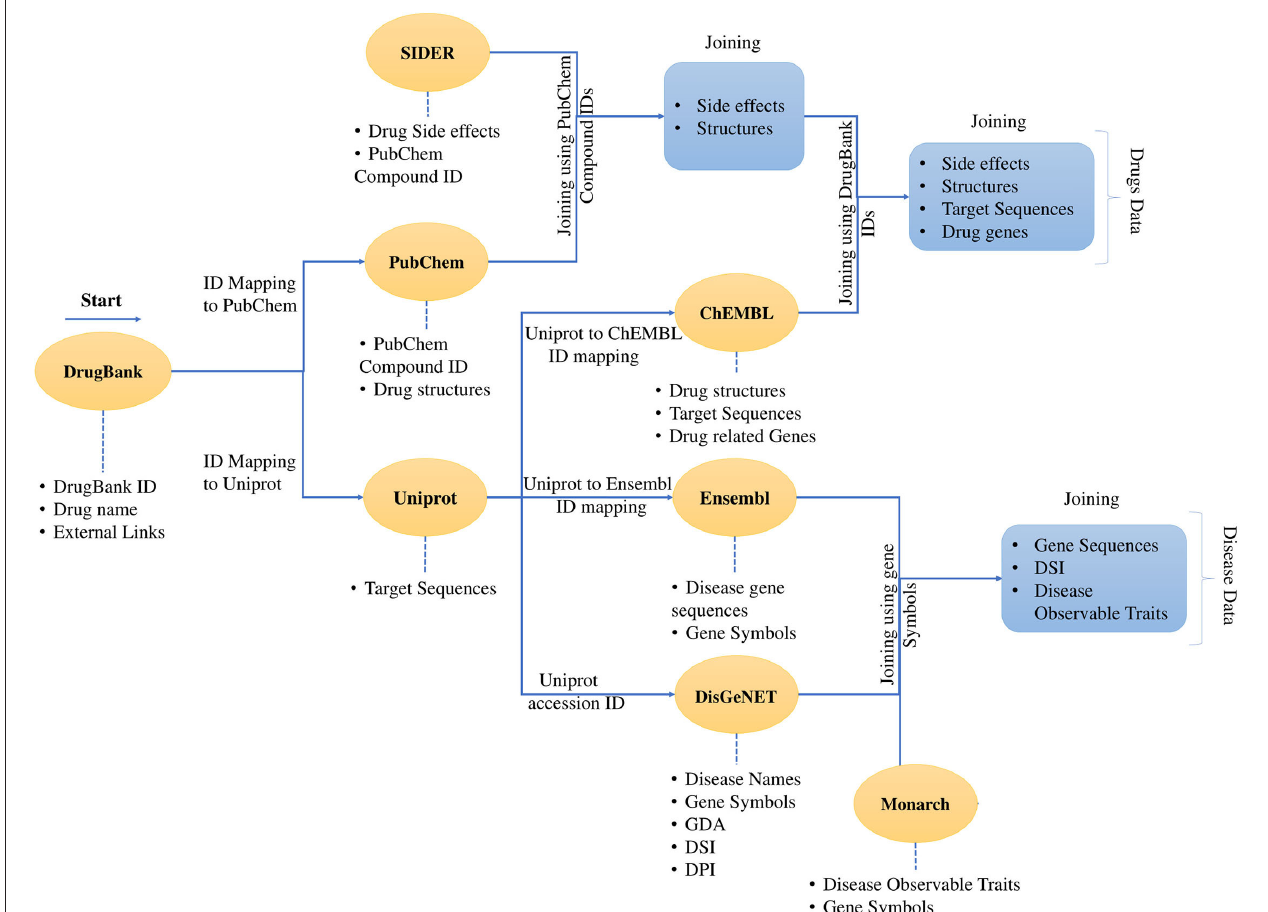
FIGURE 2 | Process of data collection and data mapping. It shows the creation of a dataset and merging of different data sources using cross-database identifiers. The dataset contains the data for the drugs and the data for the diseases. The data download was started with DrugBank data with external links. Then the data was mapped to PubChem and Uniprot. It was followed by the mapping of the SIDER data using the PubChem IDs and the mapping continues through ChEMBL and all the four drug features are presented in a tabular form with identifiers from mentioned databases. The same process follows for the disease data, and finally, the disease data is also represented in the tabular form. The developed dataset contains the drug and disease-related data enriched with various features.